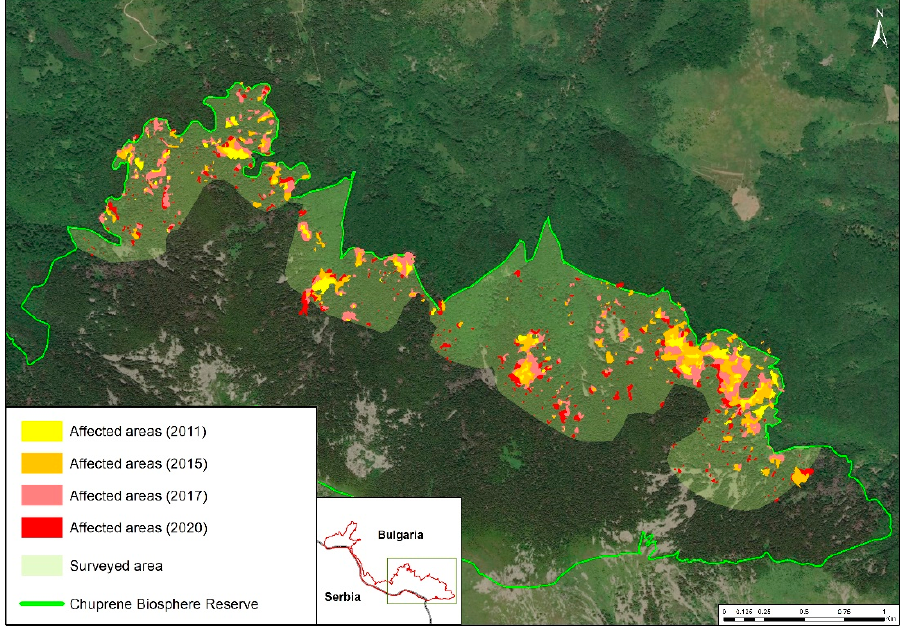
Figure 5. Ips typographus spots in areas captured in the north-eastern part of the Chuprene Reserve: 2011 and 2015 (airborne images); 2017 (original UAV images); 2020 (on satellite images).